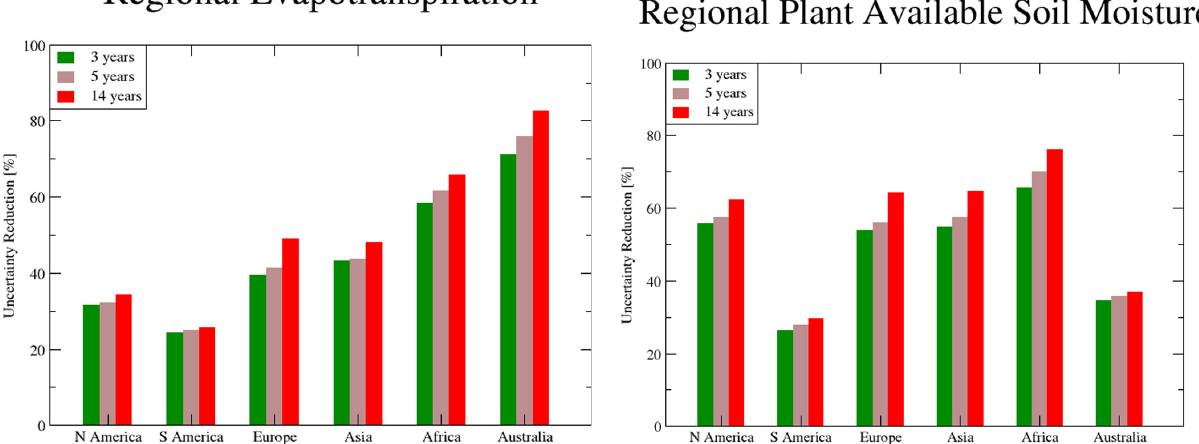
Fig. 11. Reduction in uncertainty in evapotranspiration (left hand panel) and plant available soil moisture (right hand panel) over six regions from MERIS sensor for a mission length of 3yr (green), 5yr (brown) and 14yr